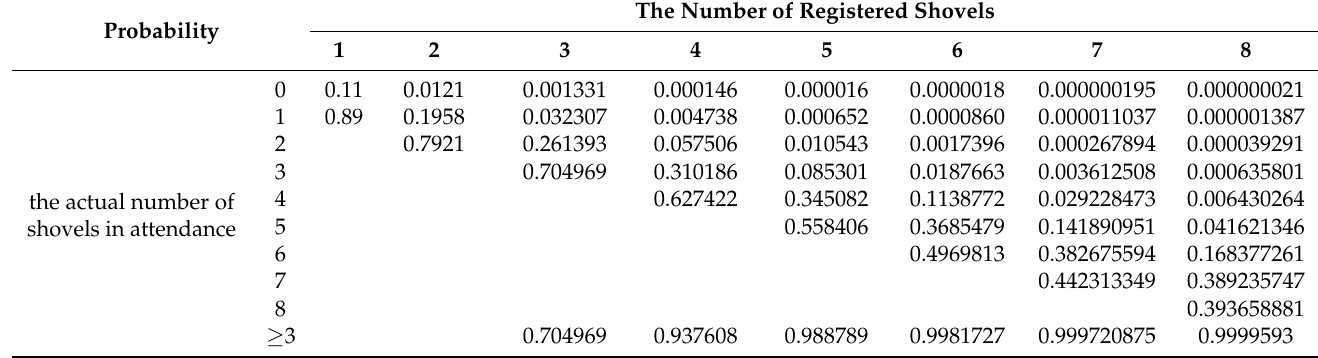
Table 2. Probability relationship between the number of registered shovels and the number of actual